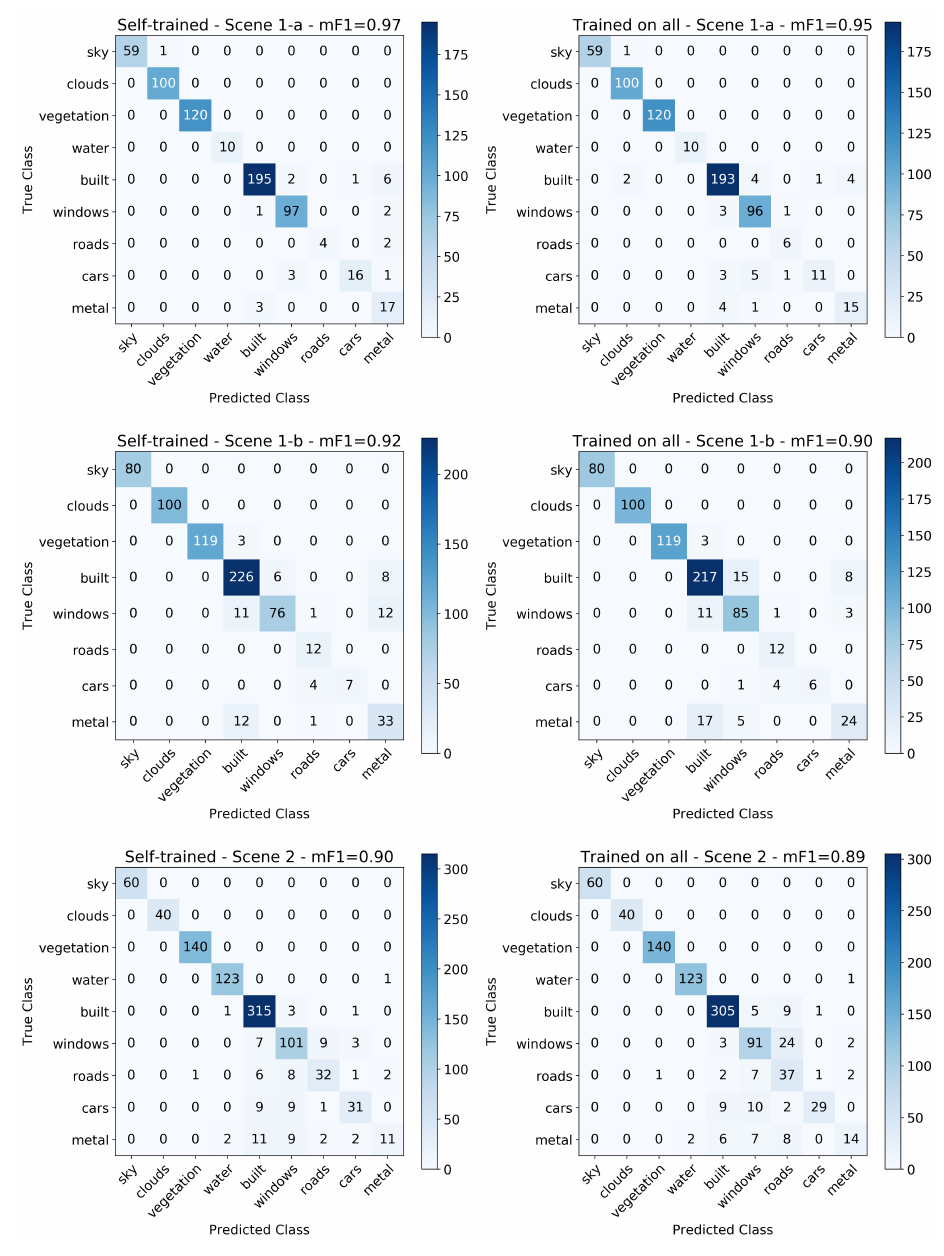
Figure A3. Confusion matrices used to derive the metrics in Table 3 for the classification of hand-labeled pixel spectra using Model 2 trained and tested on each scene separately ( left ) as opposed to a single model trained on all scenes simultaneously ( right